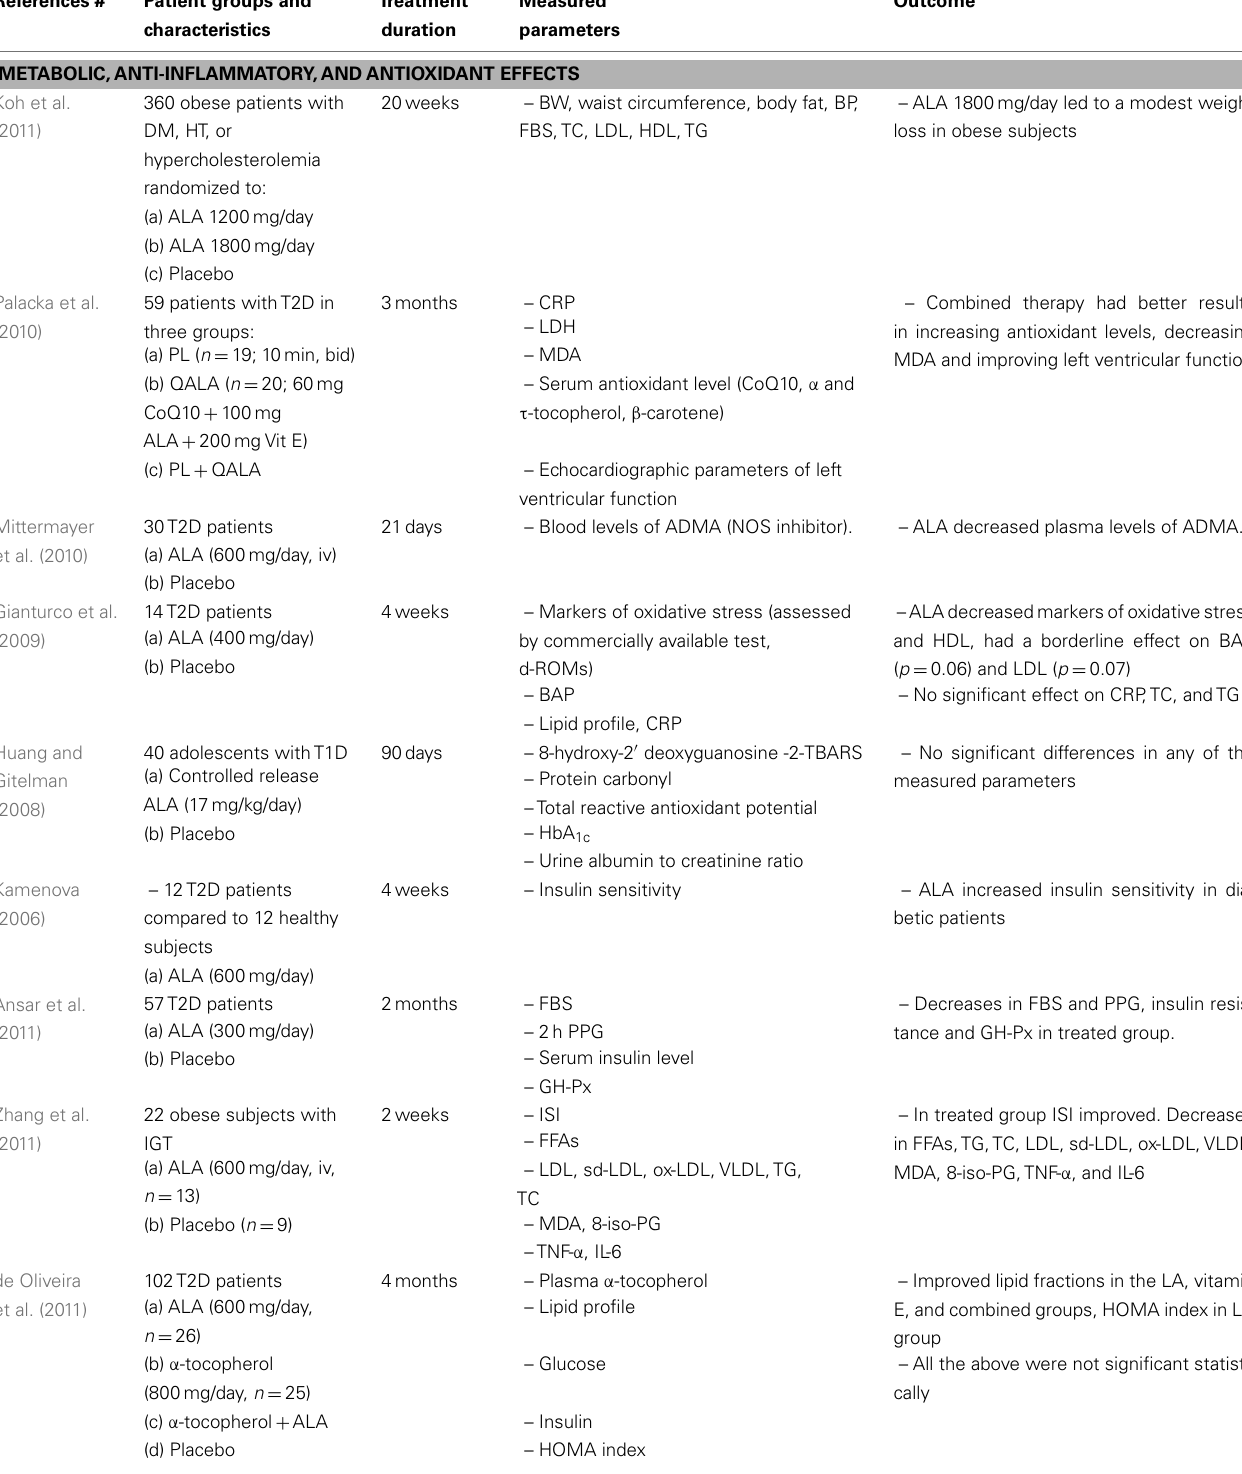
Table 1 | Selected clinical trials withALA in diabetic patients during the last